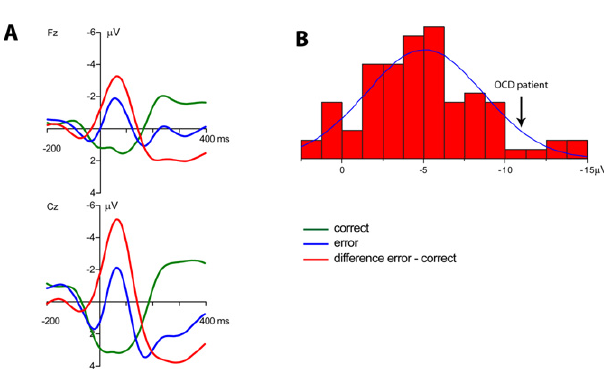
Figure 1. Event-related potentials of the normal sample. (A) Grand aver- age ERPs of the normal participants ( n = 83). A clear phasic negativity is seen in response to the errors starting at the time of the erroneous button press and reaching its maximum at about 70 ms. (B) Distribution of ERN amplitudes (quantifi ed as the mean amplitude 0–100 ms of the error – correct difference wave) in the normal sample. The amplitude of the OCD patient is marked by an arrow.